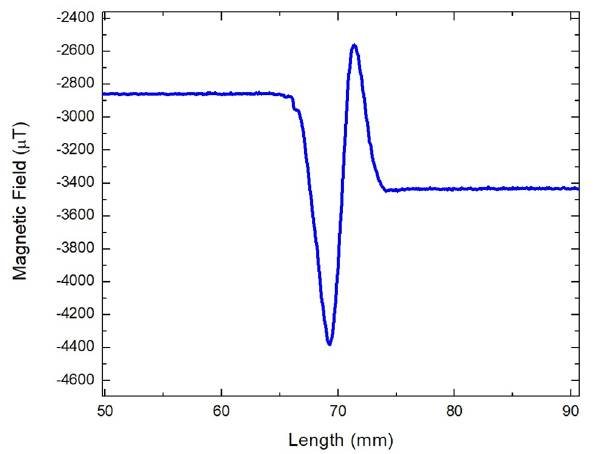
Fig. 21 Experimental result of magnetic field Z of a rectangular defect C1 with ordered magnetic